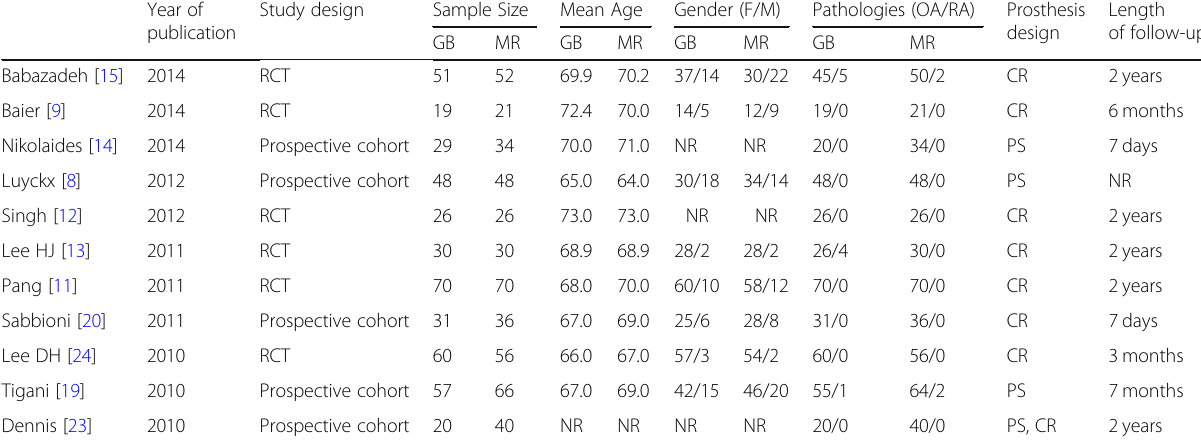
Table 1 The major characteristics of the included trails